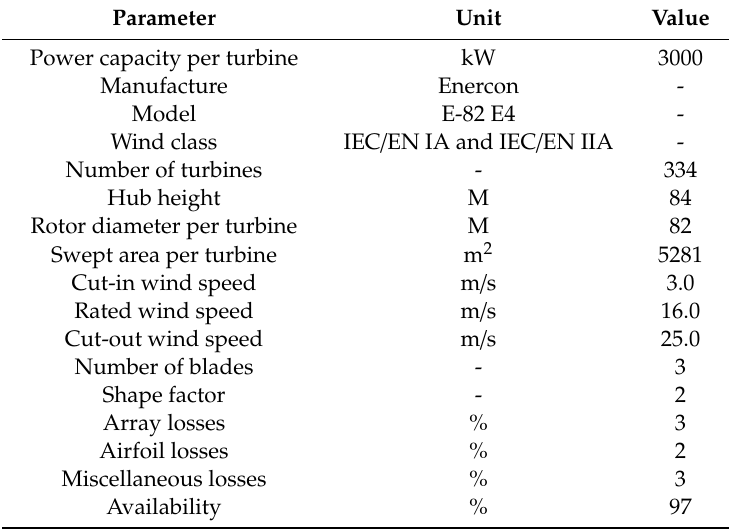
Table 4. Specifications of the wind